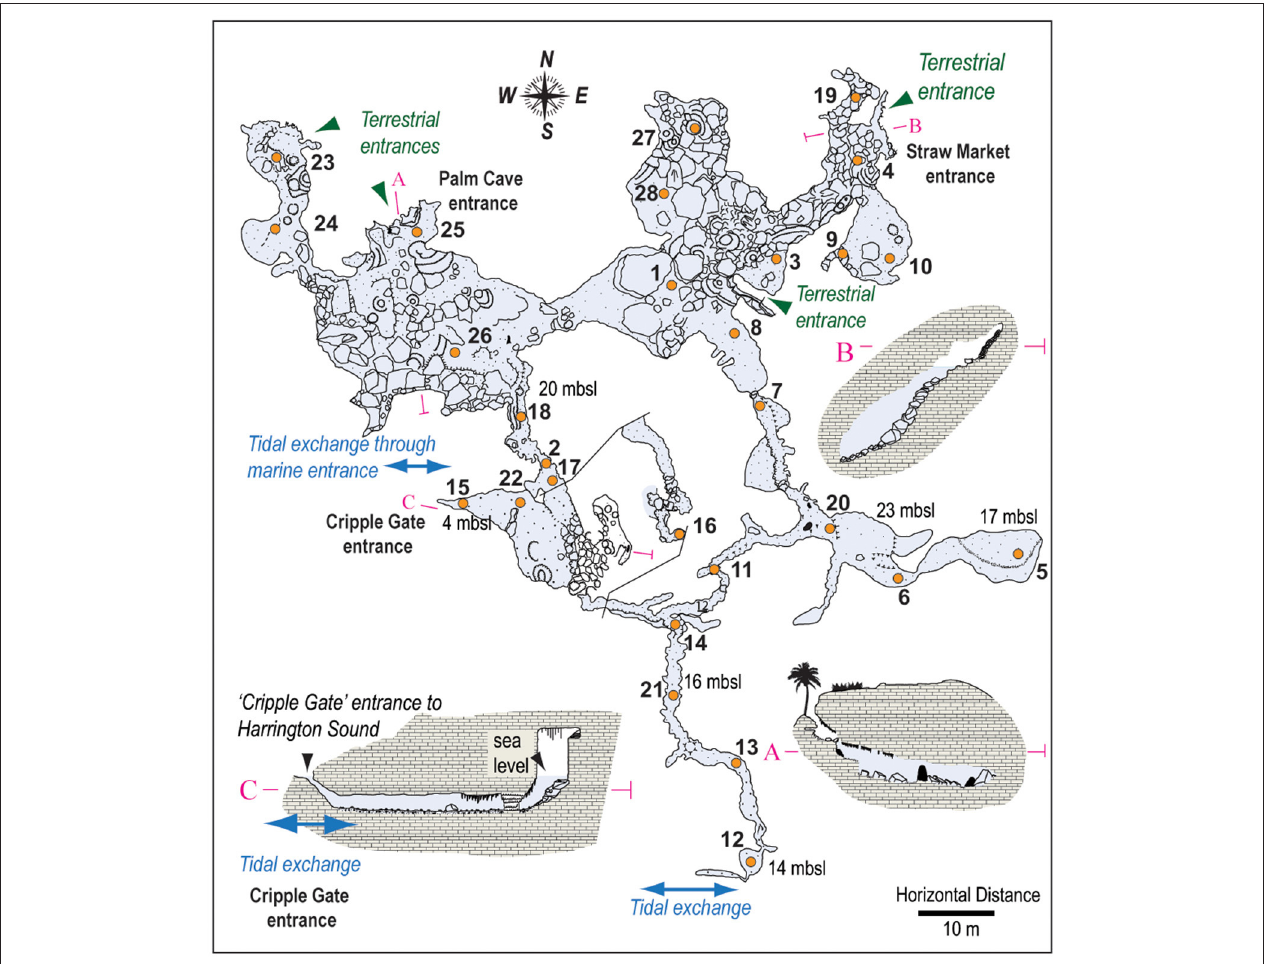
FIGURE 3 | Detailed wall map of Palm Cave, showing explored cave passages that provide direct access to the subterranean estuary, with locations of surface sediment samples (orange circles) and cave entrances (adapted from original survey of Jason Richards). Maps and surface sample locations for Green Bay Cave, and Cow Cave and Deep Blue are provided elsewhere ( van Hengstum and Scott, 2012; Little and van Hengstum, 2019).